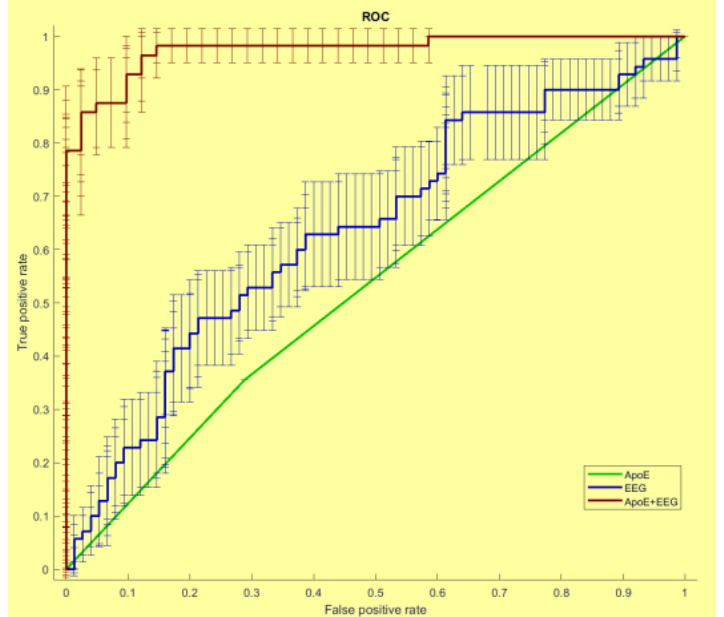
Figure 1. The receiver operating characteristic (ROC) curves illustrating the classification of the Stable and Converted MCI individuals based on the Apo-E (red line), SW (green line) and Apo-E and SW (blue line) values. The area under the (ROC) curve (AUC) was, respectively, 0.52, 0.64 and 0.97. Adapted from [45].